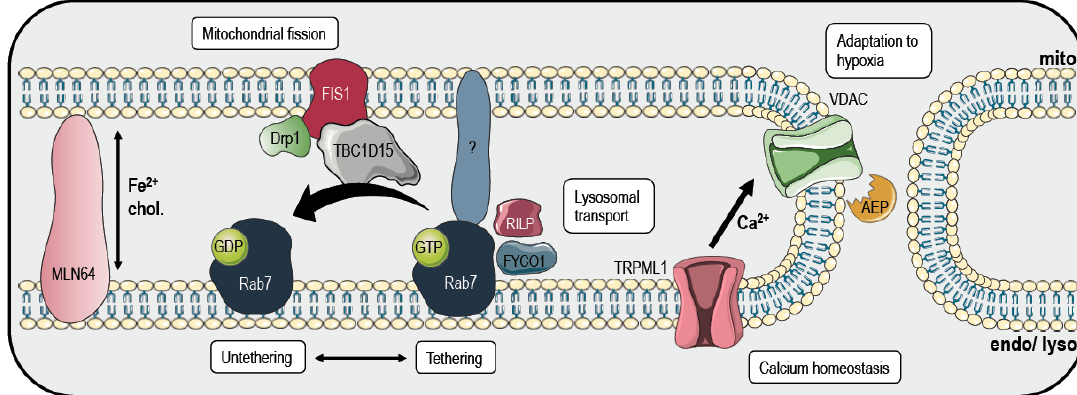
Figure 3. Signaling at mitochondria–lysosome contact sites. GTP-bound Rab7 is important for